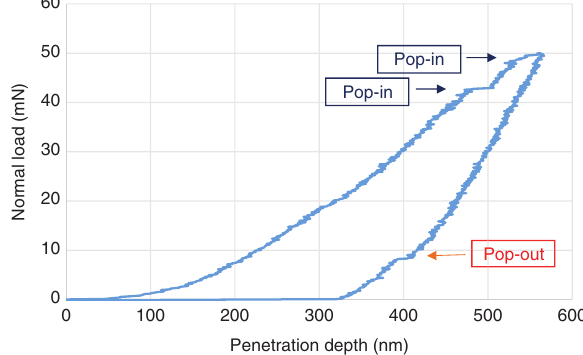
Figure 6: Normal load versus penetration depth curve of silicon wafer for low loading/unloading rate (1